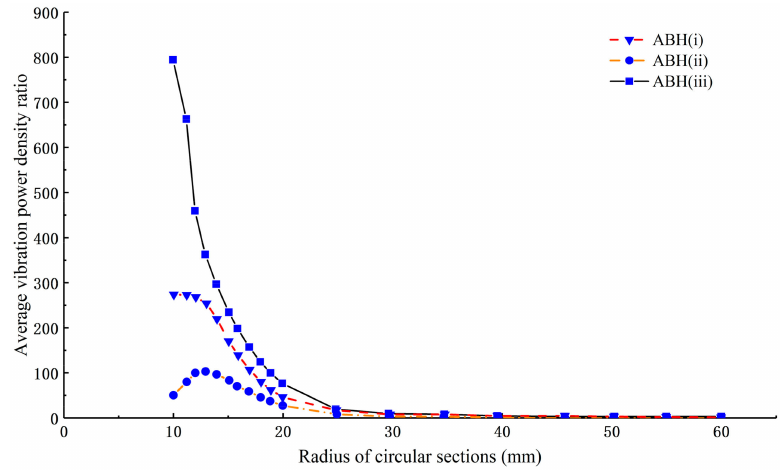
Figure 7. Average vibration power density ratios at excitation frequencies of 1000 Hz.